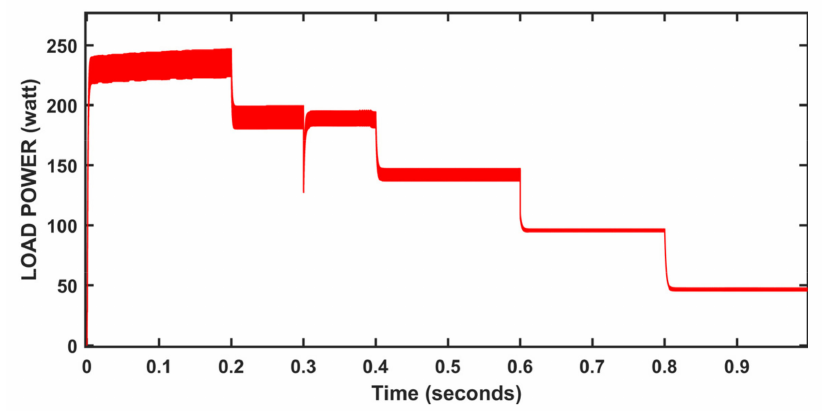
Figure 41. Performance at variable loads and varying irradiances.